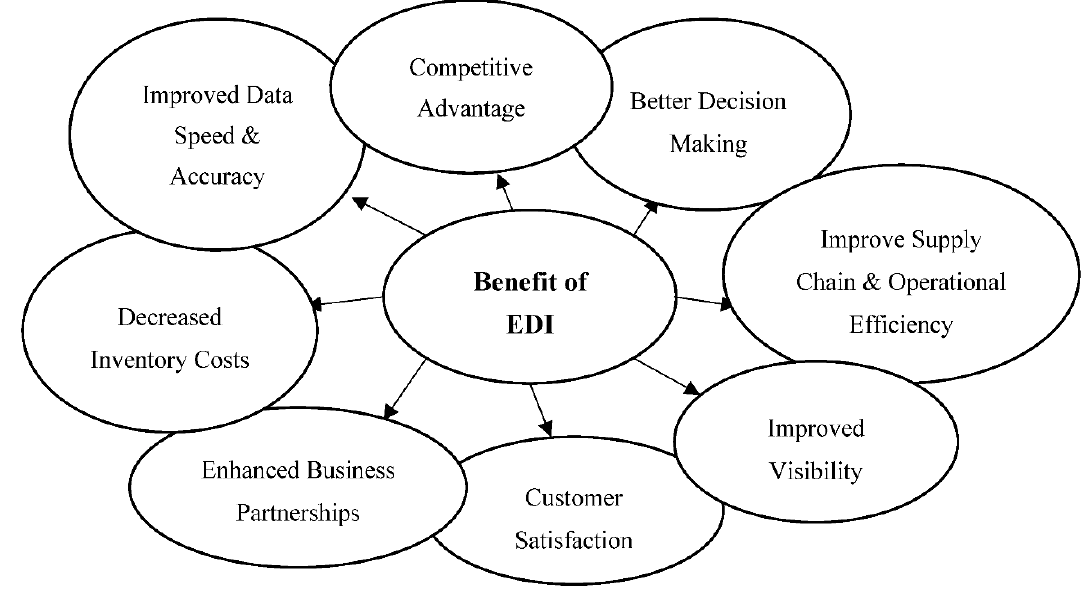
Figure 4 . The benefits of electronic data interchange . Figure 4. The benefits of electronic data